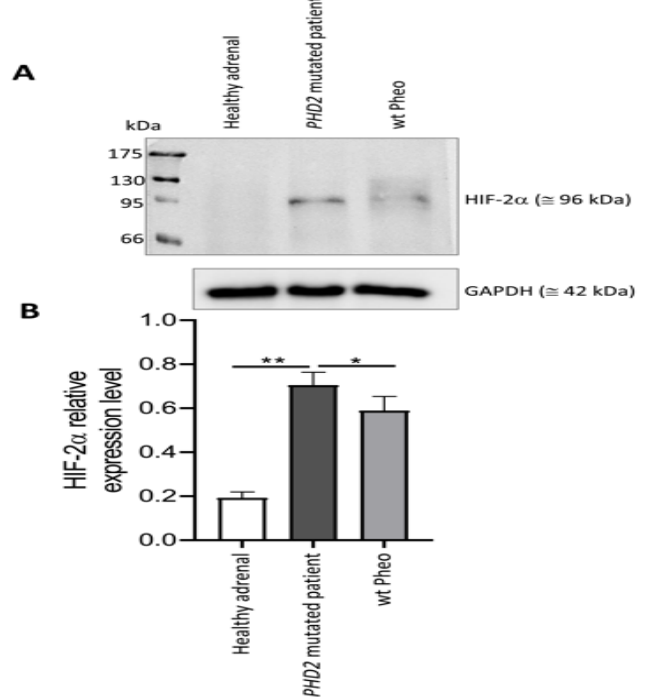
Figure 7. Western blot analysis of the HIF α protein. ( A ): Total protein lysates (40 µg of proteins) of healthy adrenal tissue, tumor specimen from the PHD2 -mutated patient and a wt Pheo tumor sample were assessed for an HIF2 α by Western blot analysis. The blot is representative of three independent preparations; GAPDH immunoblot was used as loading control. ( B ): Densitometric analysis of Western blot immunopositive band intensity: bars represent the mean of intensity ratio between HIF2 α and GAPDH in 3 independent blots ± SD. All p values were determined by unpaired one-tailed Student’s t test (* p < 0.05, ** p < 0.01).